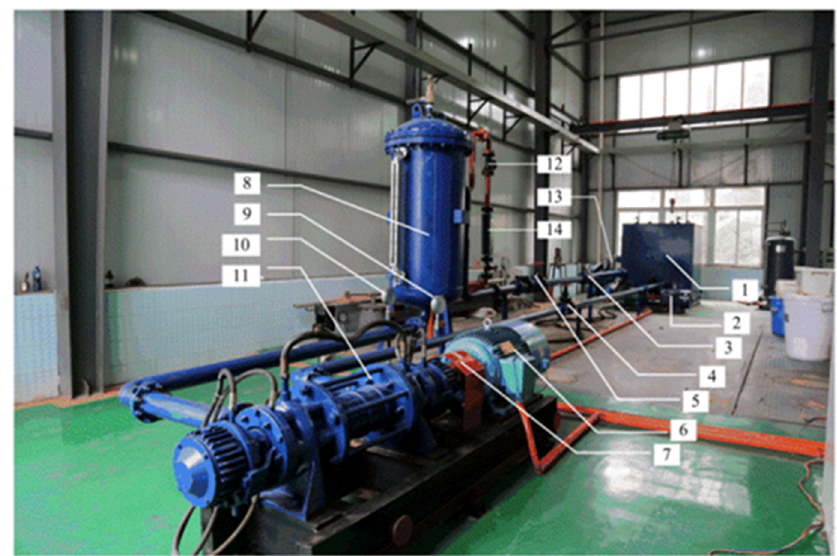
Figure 5. The multiphase pump test bench. 1. Water tank; 2. Water supply pump; 3. Flow meter; 4.